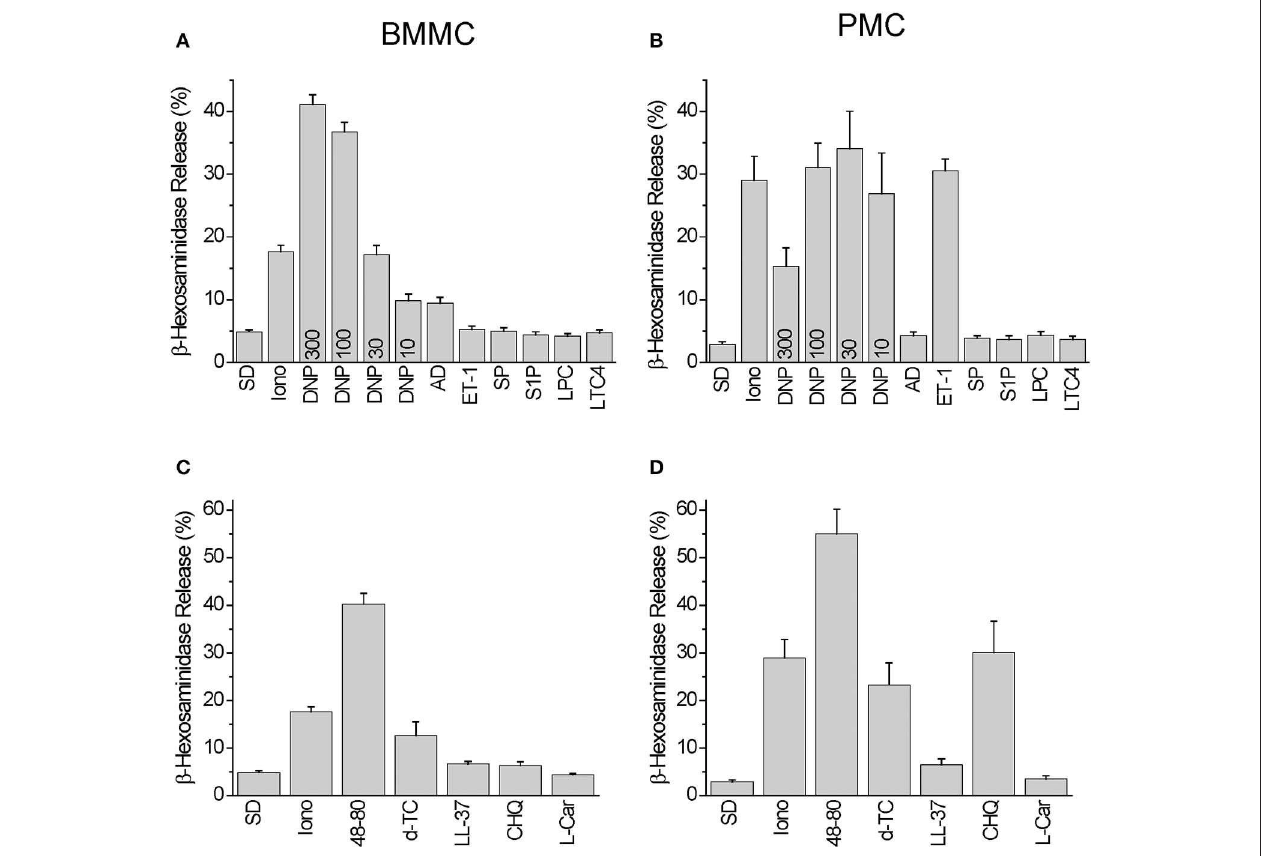
FIGURE 3 | Degranulation induced by Mrgprb2 agonists in BMMC and PMC in comparison with other established mast cell activators. Degranulation of BMMC (A,C) or PMC (B,D) isolated from wild type C57Bl6/N mice was measured using β -hexosaminidase release assay and presented as % of degranulation. Five (A,C) and six (B,D) independent preparations were measured. The PMC were stimulated with: vehicle solution (SD- spontaneous degranulation), 10 µ M of ionomycin (Iono), 10ng/ml DNP (DNP10), 30ng/ml DNP (DNP30), 100ng/ml DNP (DNP100), 300ng/ml DNP (DNP300), 10 µ M Adenosin (AD), 100nM Endothelin − 1 (ET-1), 10 µ M Substance P (SP), 10 µ M Sphingosine-1-phosphate (S1P), 10 µ M Lysophosphatidylcholine (LPC), 200nM Leukotriene C4 (LTC4), 50 µ g/ml Compound 48/80 (48-80), 30 µ g/ml Tubocurarine (d-TC), 3 µ M LL-37 (LL-37), 500 µ M Chloroquine (CHQ), 300 µ M L-Carnosine